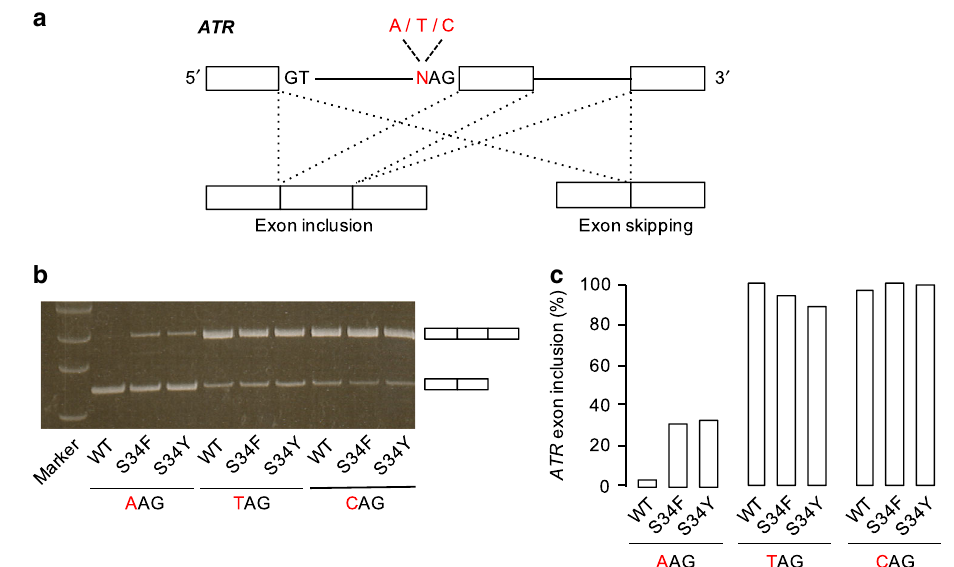
Fig. 5 Minigene-splicing assay. a Schematic diagram of ATR minigene designed for the splicing assay, which has different nucleotide A or T at the − 3 position of the 3 ′ splice site. The minigene exons are shown as boxes, and introns as solid lines. Two different pre-mRNA splicing patterns are shown as exon inclusion and exon skipping. The RNA product of the exon inclusion is derived from the removal of two introns and junction of three exons, whereas that of the exon skipping is produced by the junction of exons at both ends. b Gel electrophoresis of RT-PCR products from HEK293 cells expressing WT or mutants of U2AF1. Upper fragments correspond to the product by the exon inclusion, and lower fragments correspond to that by the exon skipping. Raw image data of gel electrophoresis are shown in Supplementary Fig. 13. c The ratio of ATR exon inclusion and the skipping is quanti fi ed from the result of ( b ), and compared based on the amount from cells expressing WT with TAG